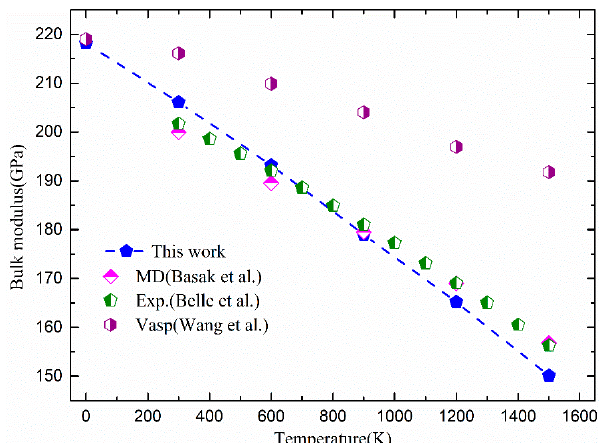
Figure 4. Variation of the bulk modulus of pure UO 2 versus temperature. For comparison, the ex- periment studies by Belle et al. [33], the Vasp data by Wang et al. [26] and the MD results by Basak et al. [23] are included.